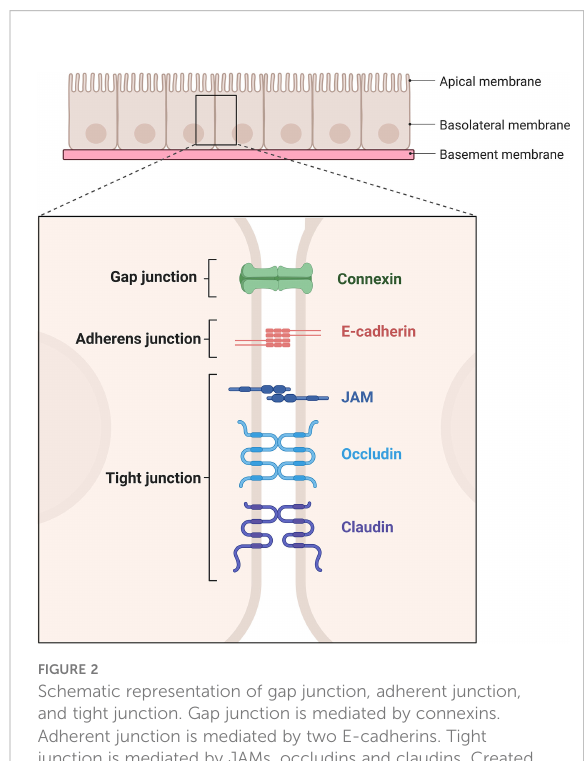
FIGURE 2 Schematic representation of gap junction, adherent junction, and tight junction. Gap junction is mediated by connexins. Adherent junction is mediated by two E-cadherins. Tight junction is mediated by JAMs, occludins and claudins. Created with